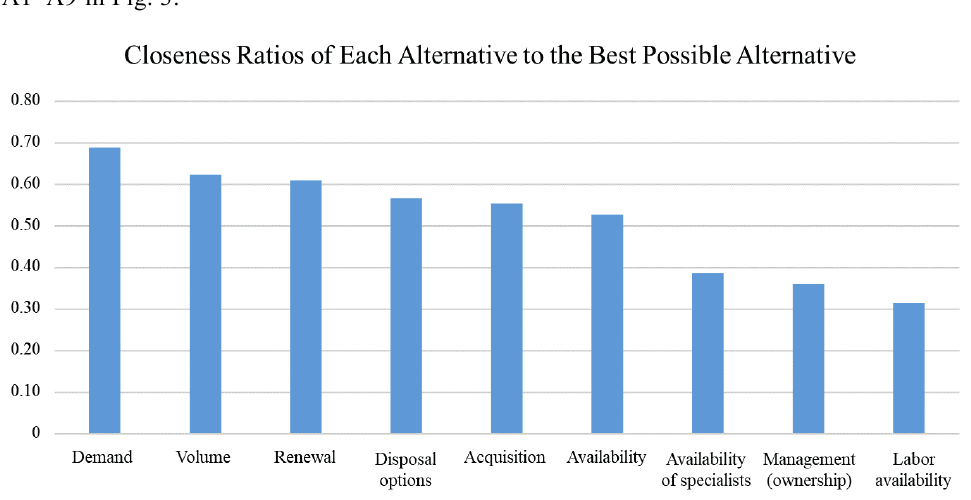
Fig. 3. Prioritisation of